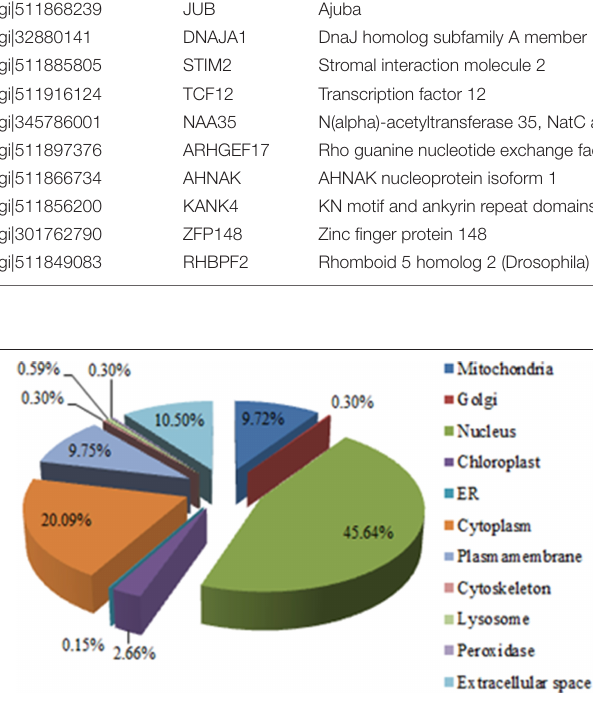
FIGURE 2 | Subcellular localization of the DEPs in Mv.1.Lu cells infected with PS.